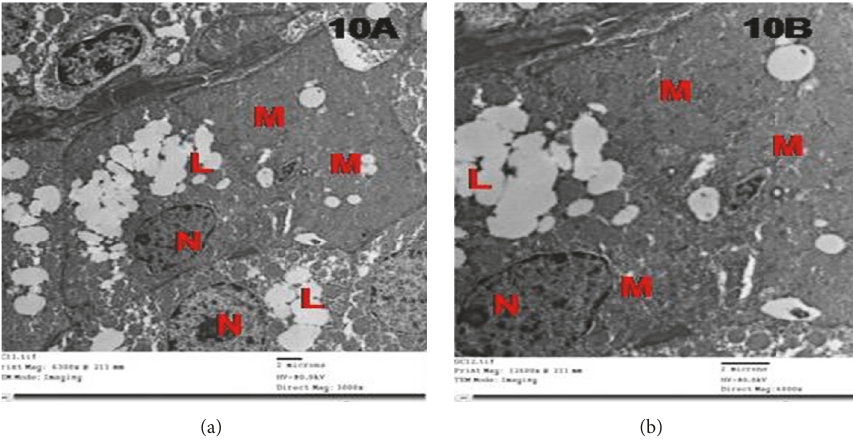
Figure 10: Electron micrographs of the adrenal cortex in group IV showing ZG cells showing euchromatic nuclei with peripheral clumps of heterochromatin (N). Note numerous normal mitochondria (M) and decreased lipid droplets compared to group III.